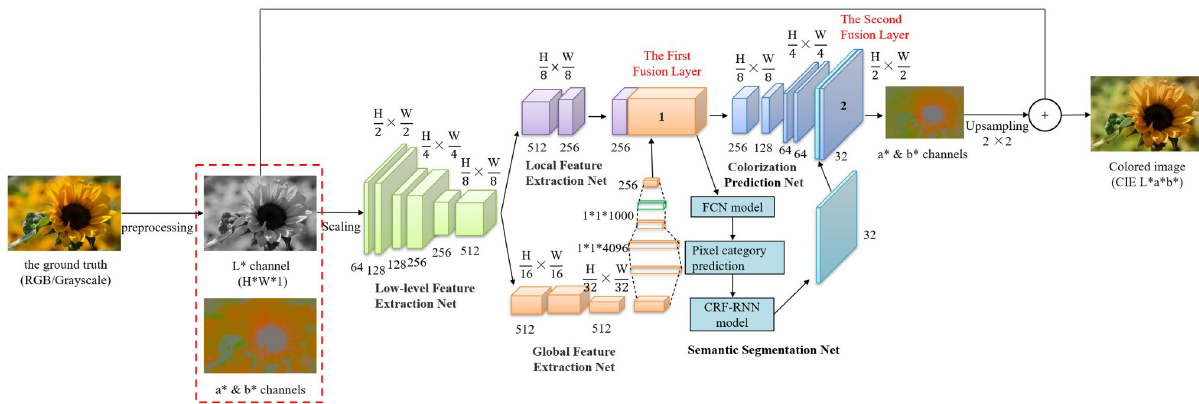
Fig 2. Our model. Some semantic segmentation information of the image can help the prediction network understand the content of the image and coloring accurately.